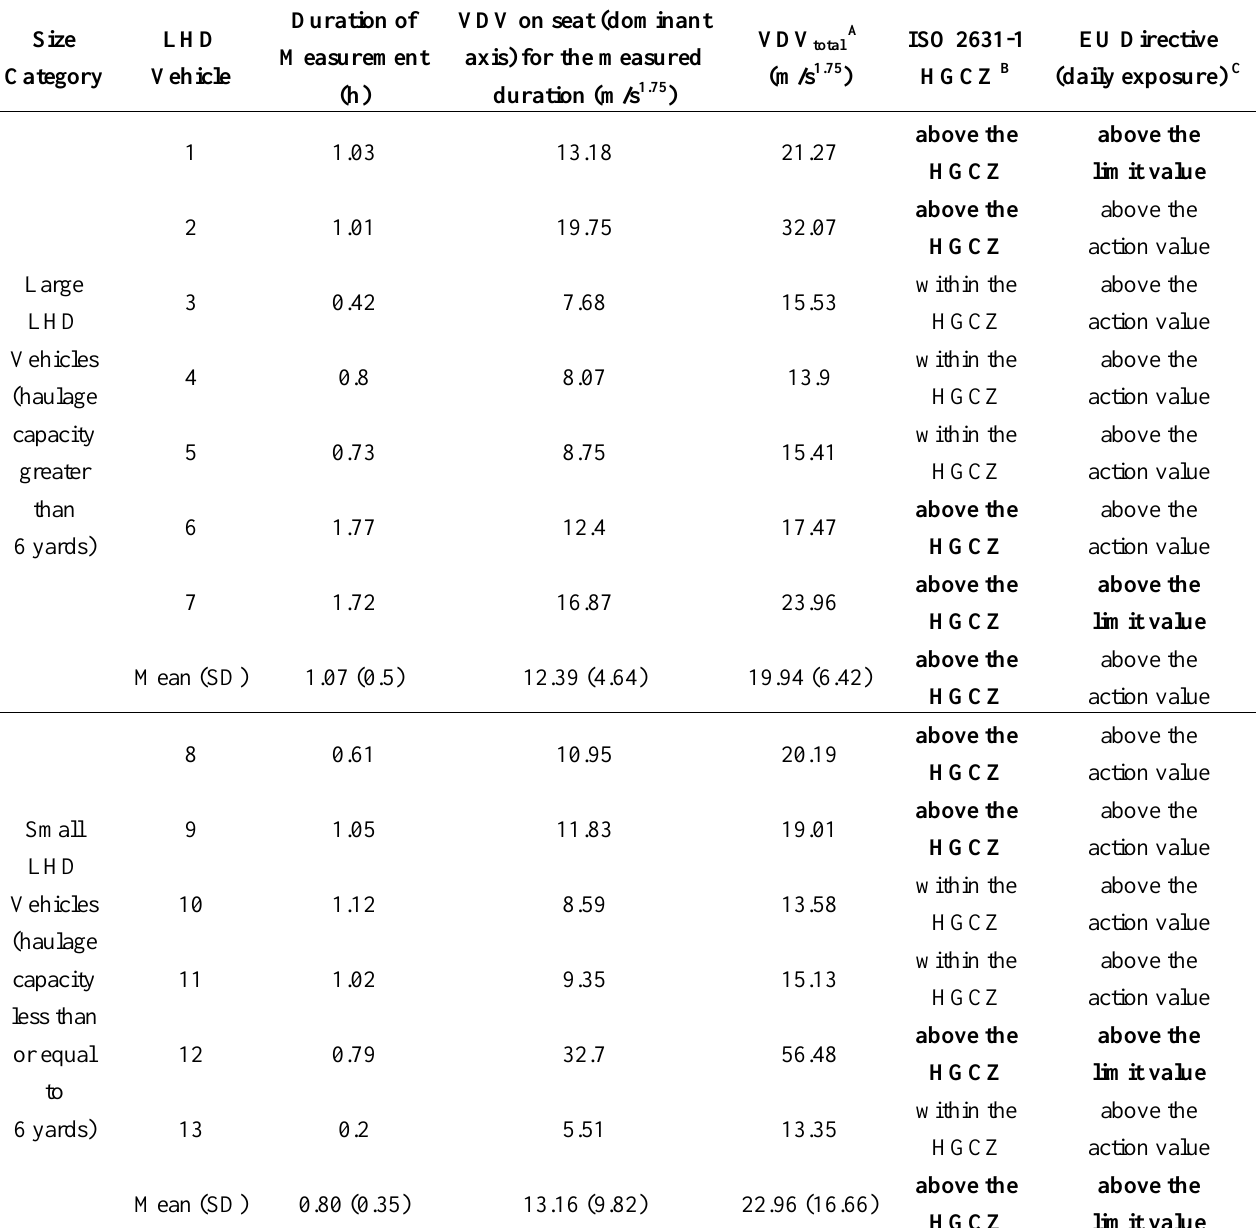
Table 4. Determination of health risk, to the LHD operator, according to ISO 2631-1 HGCZ and European Union Directive daily exposure standards based on the estimated 8-hour vibration dose value, VDV total